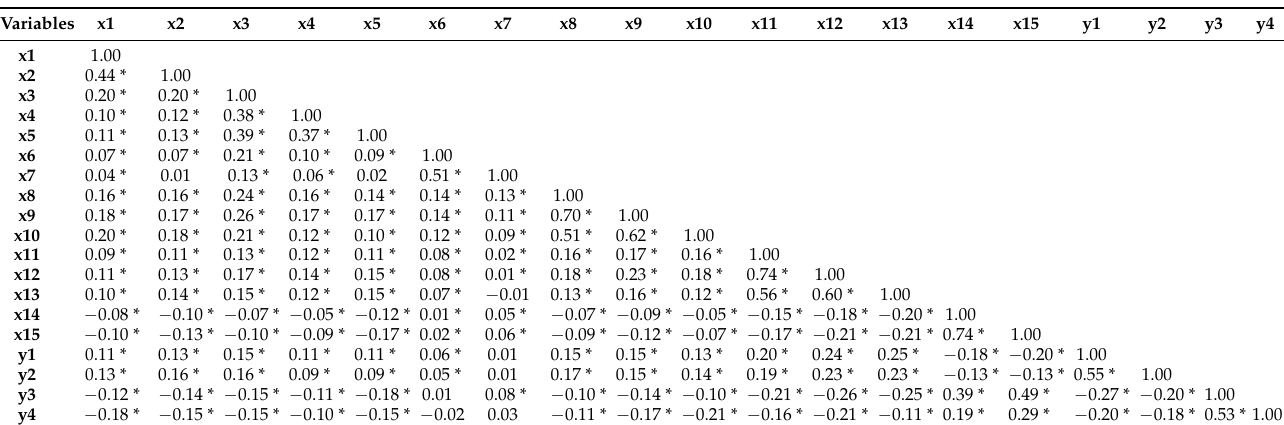
* p < 0.01 x1: relationship with father, x2: relationship with mother, x3: parental discipline (study), x4: parental discipline (life), x5: parental discipline (electronics), x6: parent–school contact (initiative), x7: parent–school contact (passive), x8: teacher supervision (attention), x9: teacher supervision (question), x10: teacher supervision (commendation), x11: peer positive behavior (excellent grades), x12: peer positive behavior (hard-working), x13: peer positive behavior (purposeful), x14: peer misconduct (school performance), x15: peer misconduct (life behavior), y1: pro-sociality (mannered), y2: pro-sociality (friendly), y3: misconduct (behavior), y4: misconduct (language and